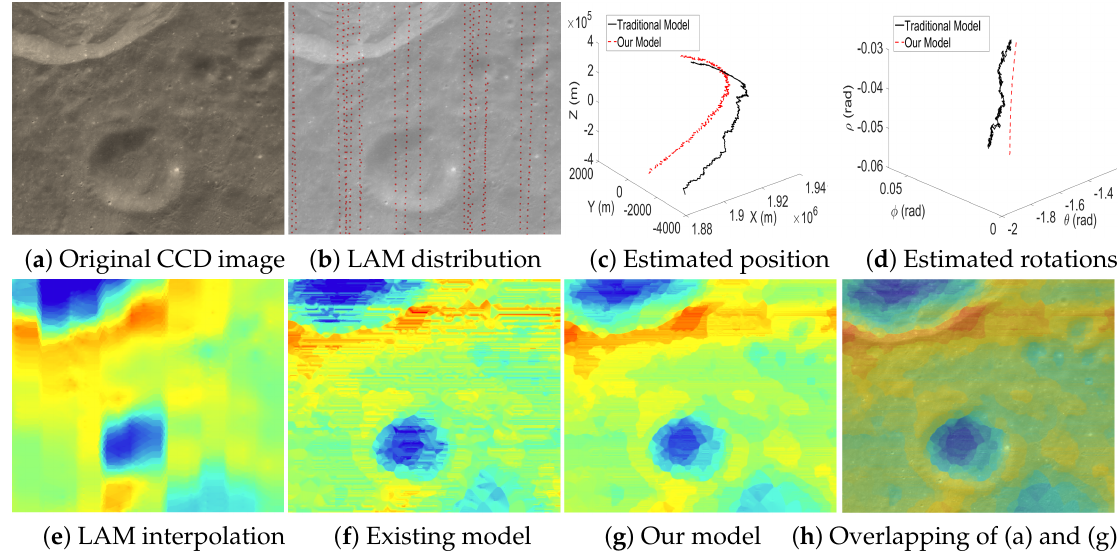
Figure 15. Case 5 with a sparse LAM distribution.